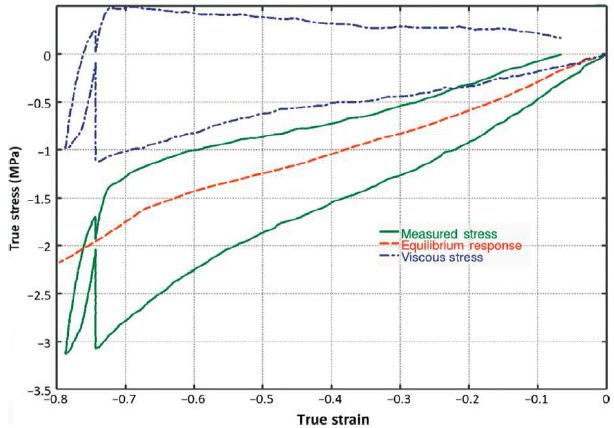
Figure 11. The strain was held constant for 10 min at a true strain of − 0.75. The experimentally measured stress (green solid line) was decomposed into equilibrium stress (red dashed line) and viscoelastic stress (blue dash-dot line) (extracted from Bergström’s book [38]).